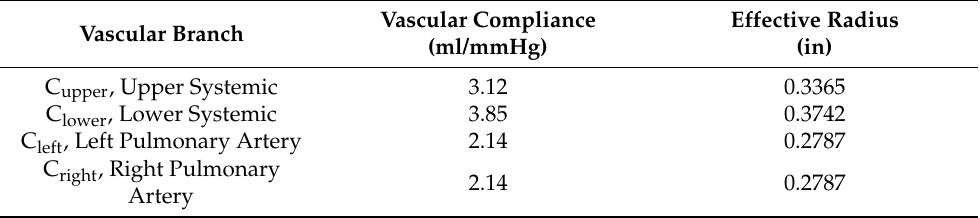
Table 2. Compliance values used in in-vitro